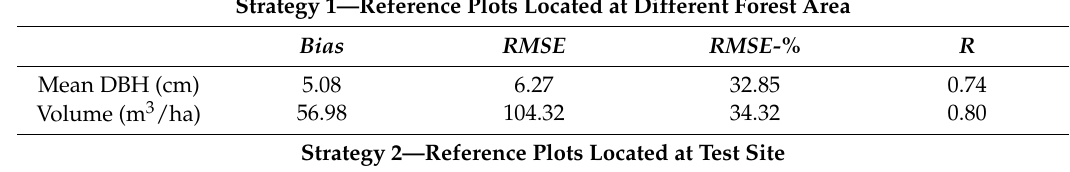
Table 3. The bias , RMSE , and correlation coefficient ( R ) for the local field reference test, comparing the results of forest inventory from ALS with three different sets of manually obtained reference